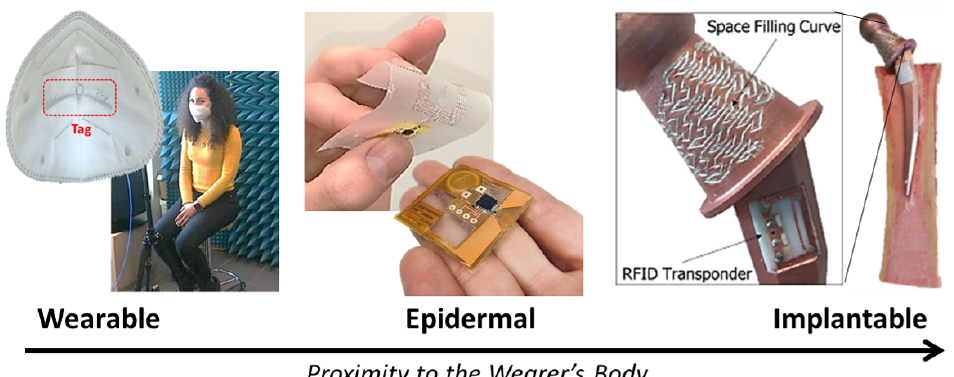
Figure 5. Examples of NFC and UHF RFID medical sensors that are categorized into three classes: wearable, epidermal, and implantable. From left to right: a wearable UHF RFID temperature sensor for monitoring coughing (image adapted with permission from Ref. [77]. © 2021, IEEE); NFC (image adapted with permission from Ref. [76]. © 2022, IEEE) and RFID (image adapted with permission from Ref. [78]. © 2022, Elsevier) sensor for analysing sweat; an implantable RFID sensor for detecting cracks (image adapted with permission from Ref. [13]. © 2021,